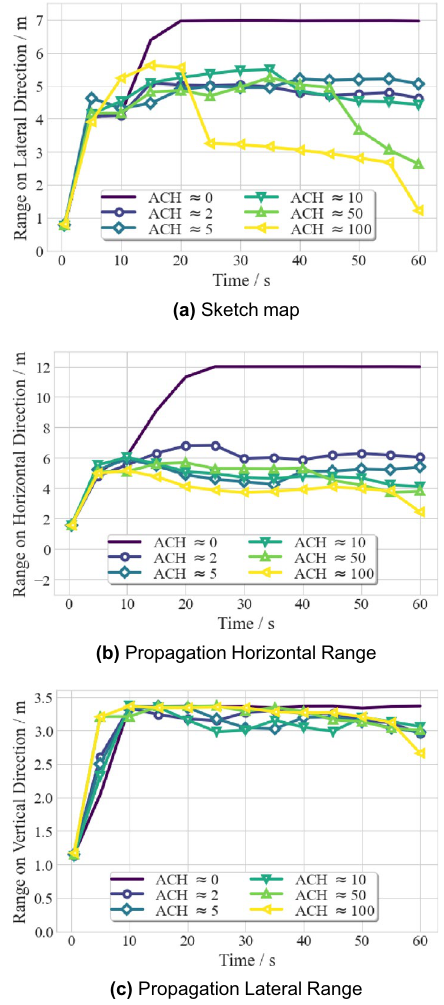
Figure 28. Propagation range of droplet cloud varies with